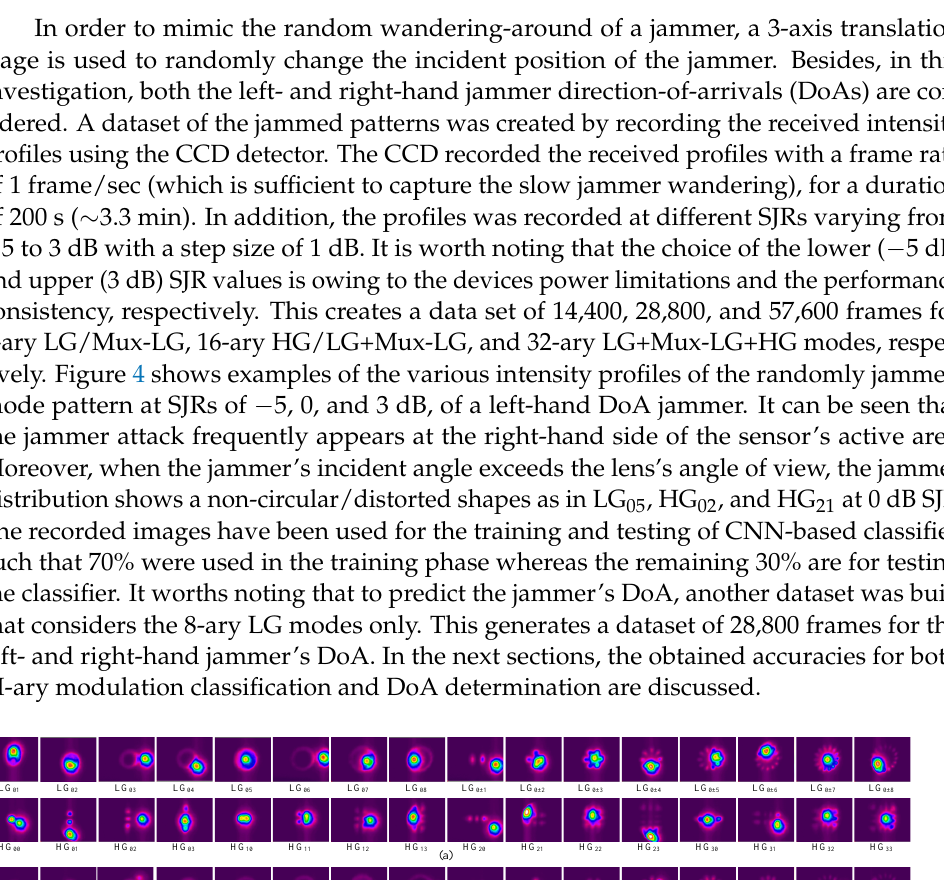
Figure 3. Measured beam width diameters using D4 σ method for ( a ) Jammer, ( b ) LG modes, ( c ) Mux-LG modes, and ( d ) HG-modes.